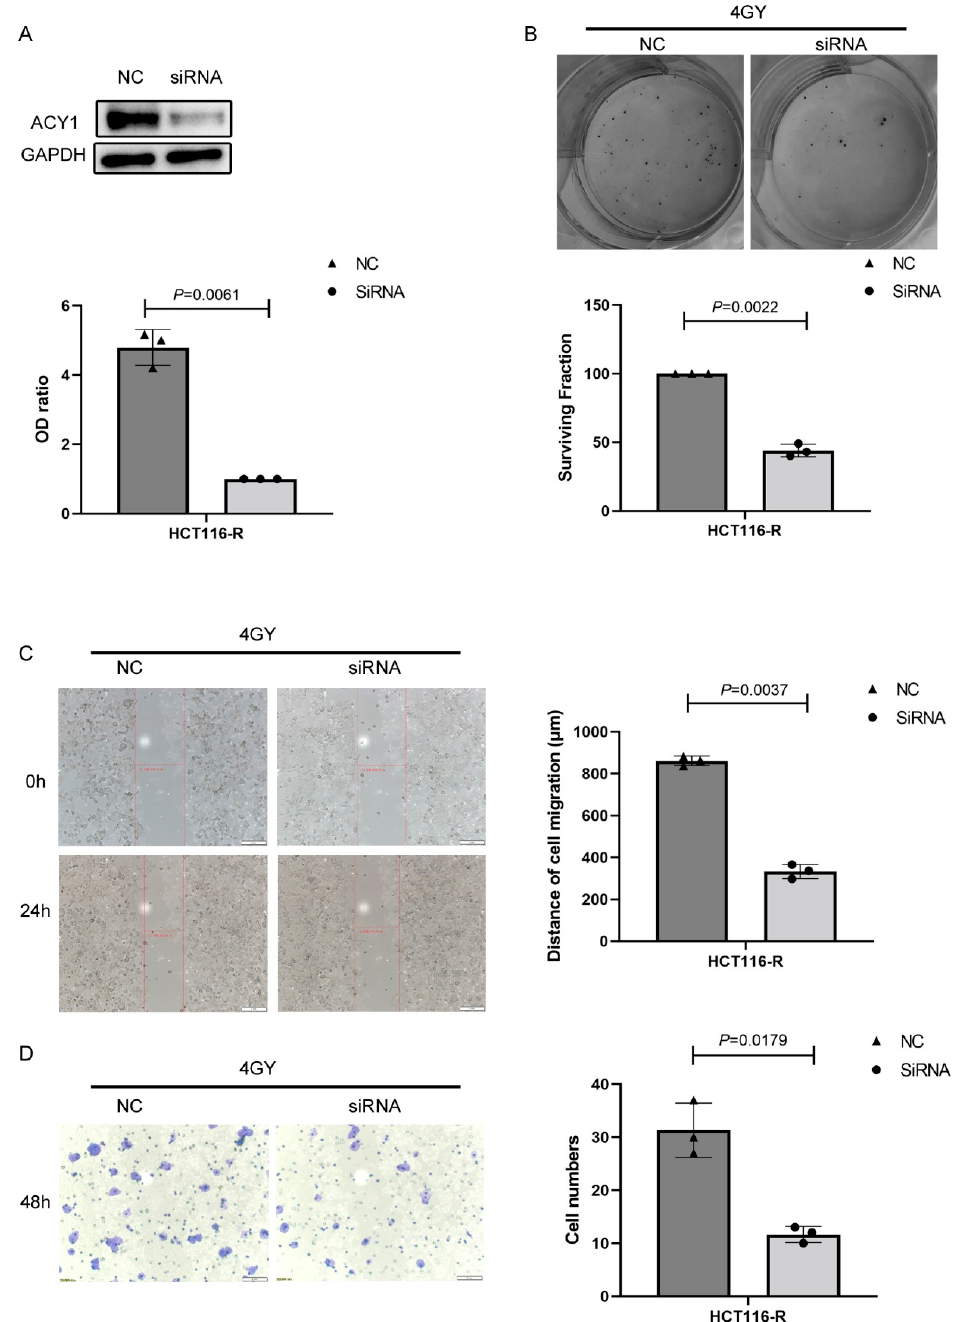
Figure 6. Silencing ACY1 in HCT116-R cells increased the sensitivity to radiation. ( A ) HCT116-R cells were transfected with siRNA-NC or siRNA-ACY1, and the protein levels of ACY1 were estimated by Western blotting. ( B ) Representative images and the survival fraction of colony formation in siRNA-NC or siRNA-ACY1 HCT116-R cells treated with 4 Gy irradiation. ( C ) Wound healing assay measuring the migration ability of HCT116-R cells transfected with siRNA-NC or siRNA-ACY1 at 24 h treated with 4 Gy irradiation. ( D ) Transwell invasion assays were performed in HCT116-R cells transfected with siRNA-NC or siRNA-ACY1 at 48 h and treated with 4 Gy irradiation. All experiments were repeated at least three times, and the data are presented as the mean ±